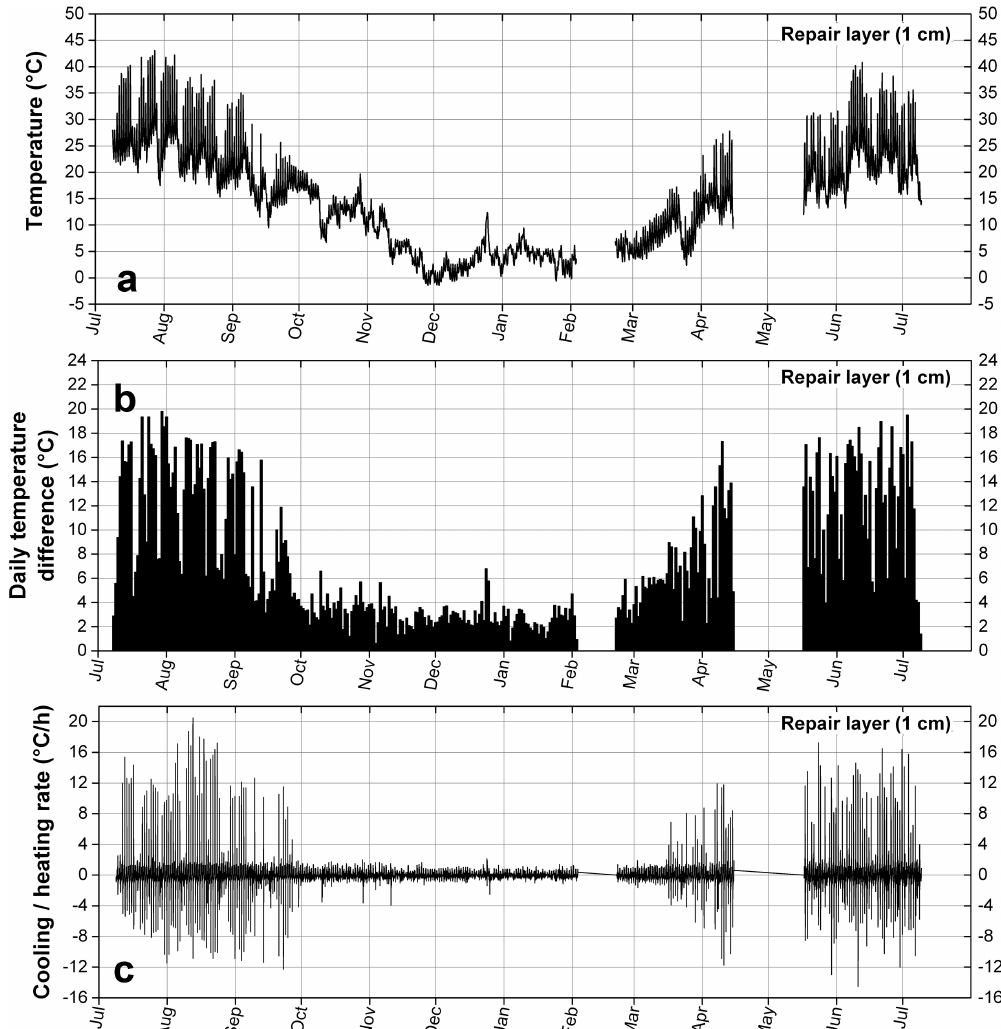
Figure 11. Temperature data measured in Notre-Dame de Vevey in the repair layer at a depth of 1 cm. ( a ) Temperature profile; ( b ) Temperature amplitude (daily temperature difference); ( c ) Rate of temperature